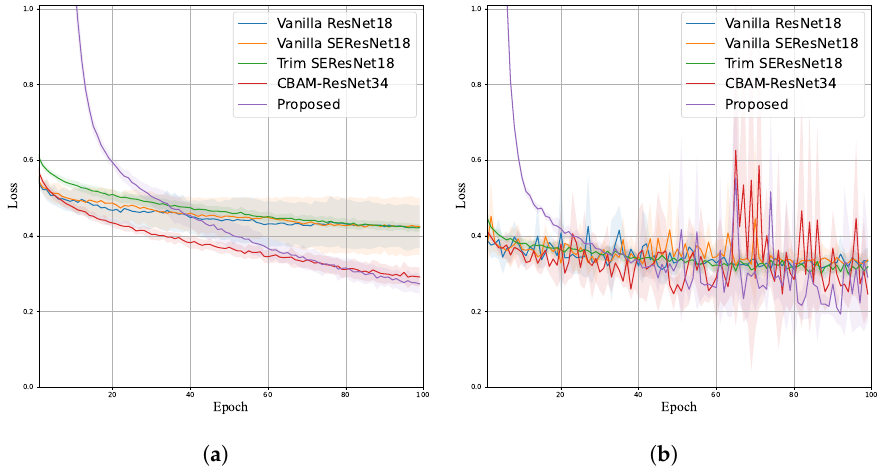
Figure 7. ( a ) Training and ( b ) Validation loss curves of the A-DSSS